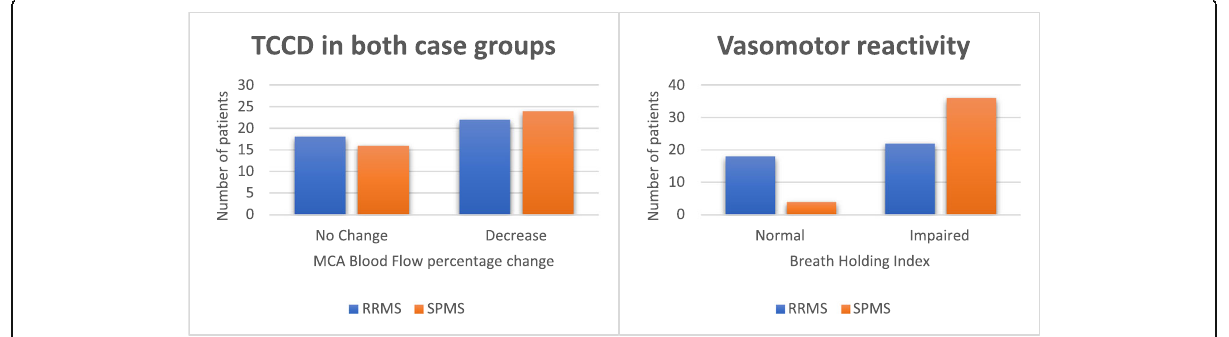
Fig. 1 TCCD assessment between 2 groups of cases as regards MCA blood flow and BHI